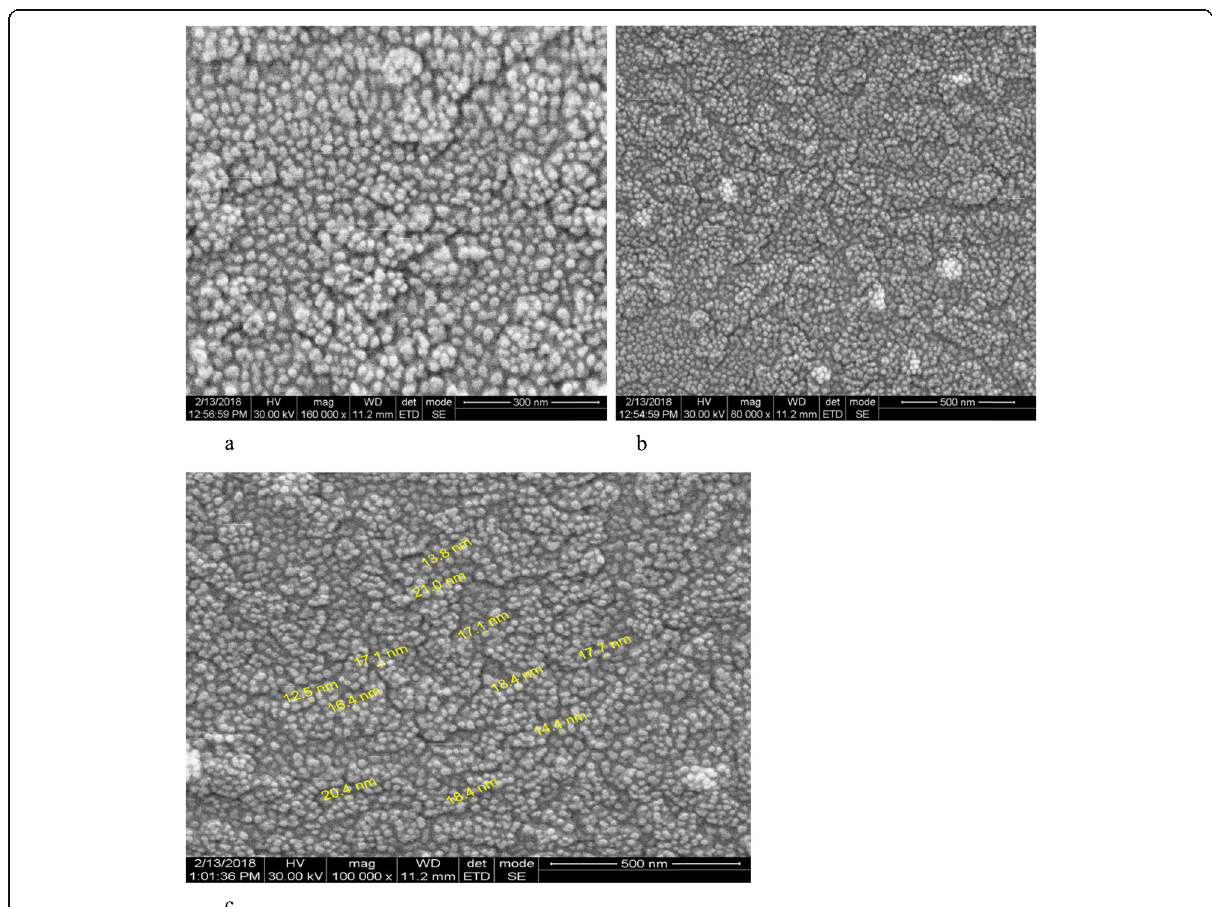
Fig. 5 a HRSEM images of the nanoparticles. b Nanoparticles showing spherical morphology. c Size of the nanoparticles measured